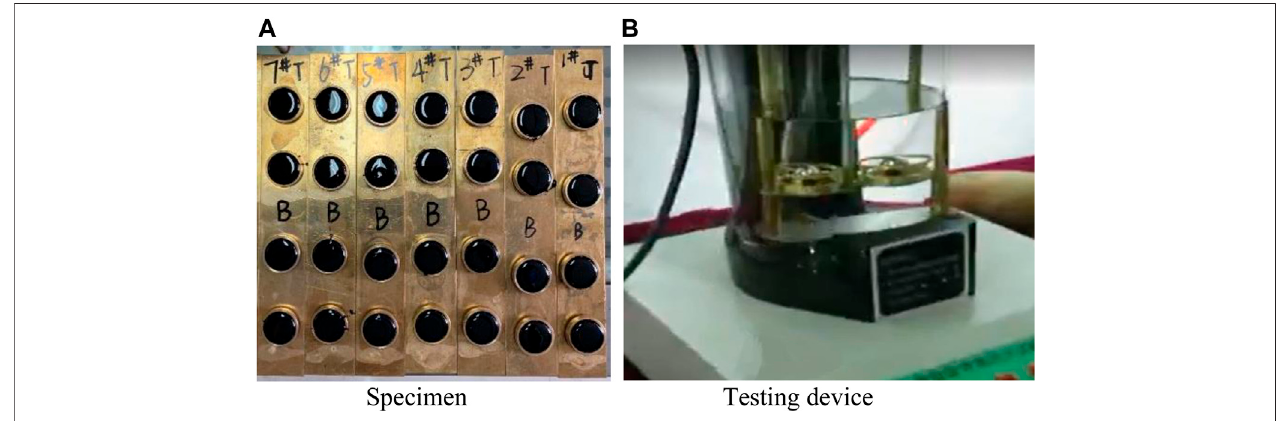
FIGURE 3 | Softening-point test. (A) Specimen. (B) Testing device.